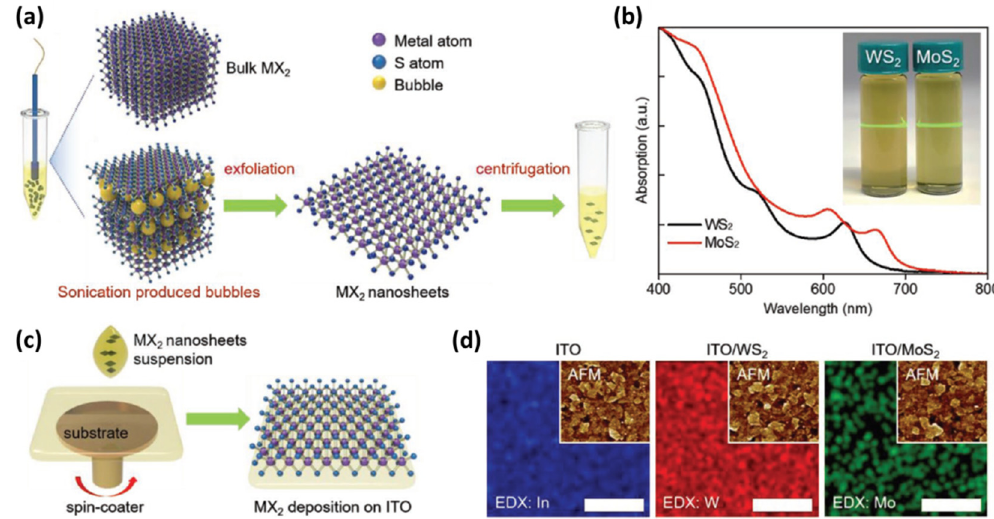
Figure 13. ( a ) The preparation process of MoS 2 and WS 2 suspensions. ( b ) Absorption spectra and the Tyndall effect in WS 2 and MoS 2 dispersions. ( c ) Schematic diagram of deposition of MoS 2 and WS 2 HTLs on substrate. ( d ) Element mapping obtained using EDX (scale bar: 2 µm). Insets exhibit AFM images of corresponding samples. Reproduced from [33]. Reprinted with permission from ref. [33]. Copyright 2019 Wiley.